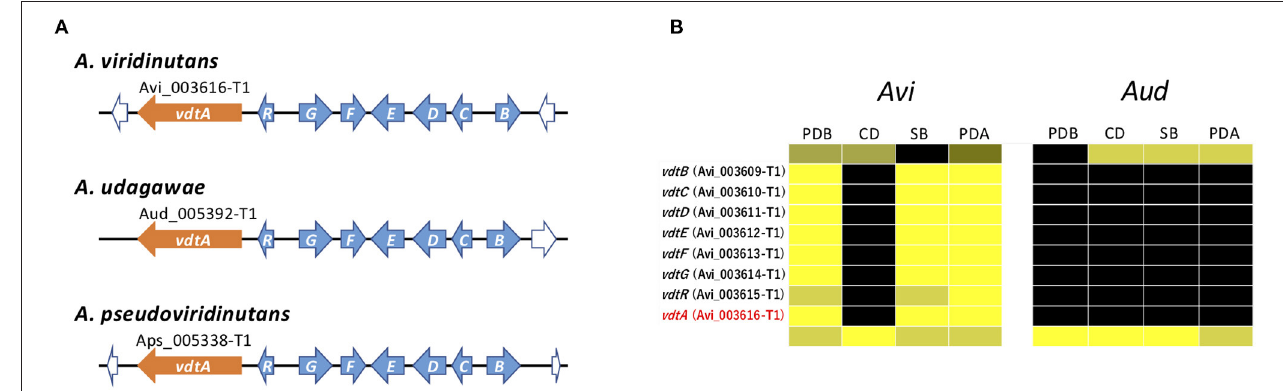
FIGURE 7 | Characterization of vdt cluster. (A) Schematic structure of the vdt cluster from A. viridinutans , A. udagawae , and A. pseudoviridinutans . The SM backbone genes (PKSs) are indicated by orange arrows. The other component genes are indicated by light blue arrows. (B) The expression profiles of vdt genes in A. viridinutans and A. udagawae shown using a heat